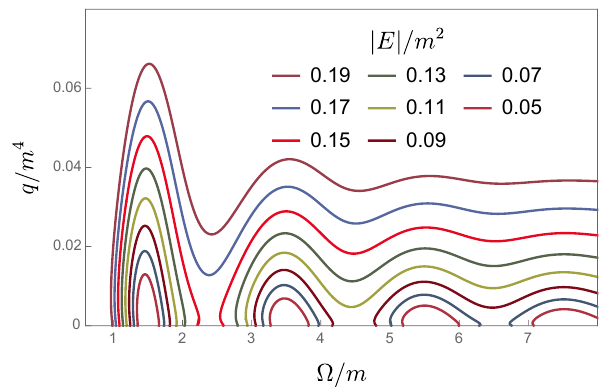
Figure 7 . The Joule heating q as a function of the frequency (cid:10) for black hole embeddings and several values of the electric